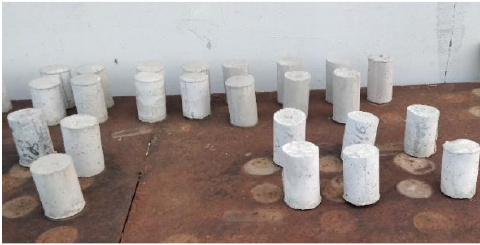
Figure 3. Specimens of concrete exposed to the open air unsheltered environment in the court of the building materials laboratory in Xanthi.